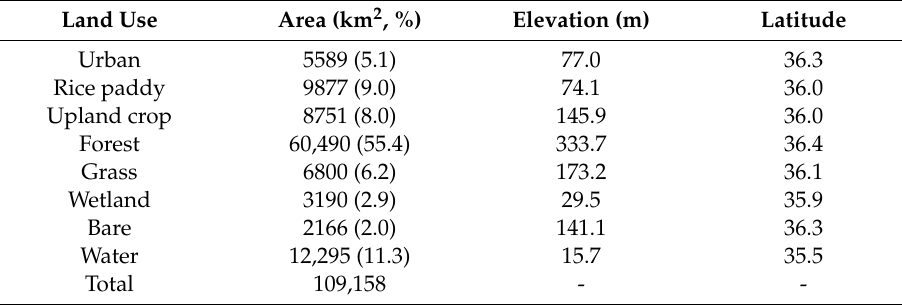
Table 1. Area, elevation, and latitude of resampled land